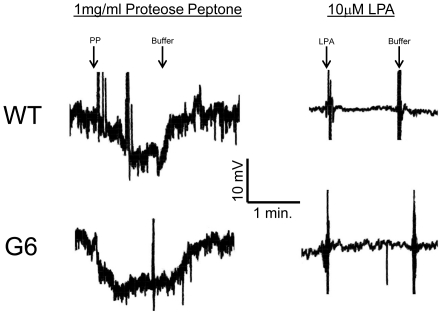
The electrophysiological responses to proteose peptone (PP) and lysophosphatidic acid (LPA) of G6.PP causes a large and reversible hyperpolarization in both wild-type and in the G6 mutant. However, the G6 mutant cannot show chemoattraction to PP. LPA does not cause any changes in membrane potential in both wild-type and G6 cells. The large upward and downward spikes are perfusion artifacts that were unavoidable during changes in bathing solutions. Figure representative of three similar traces.